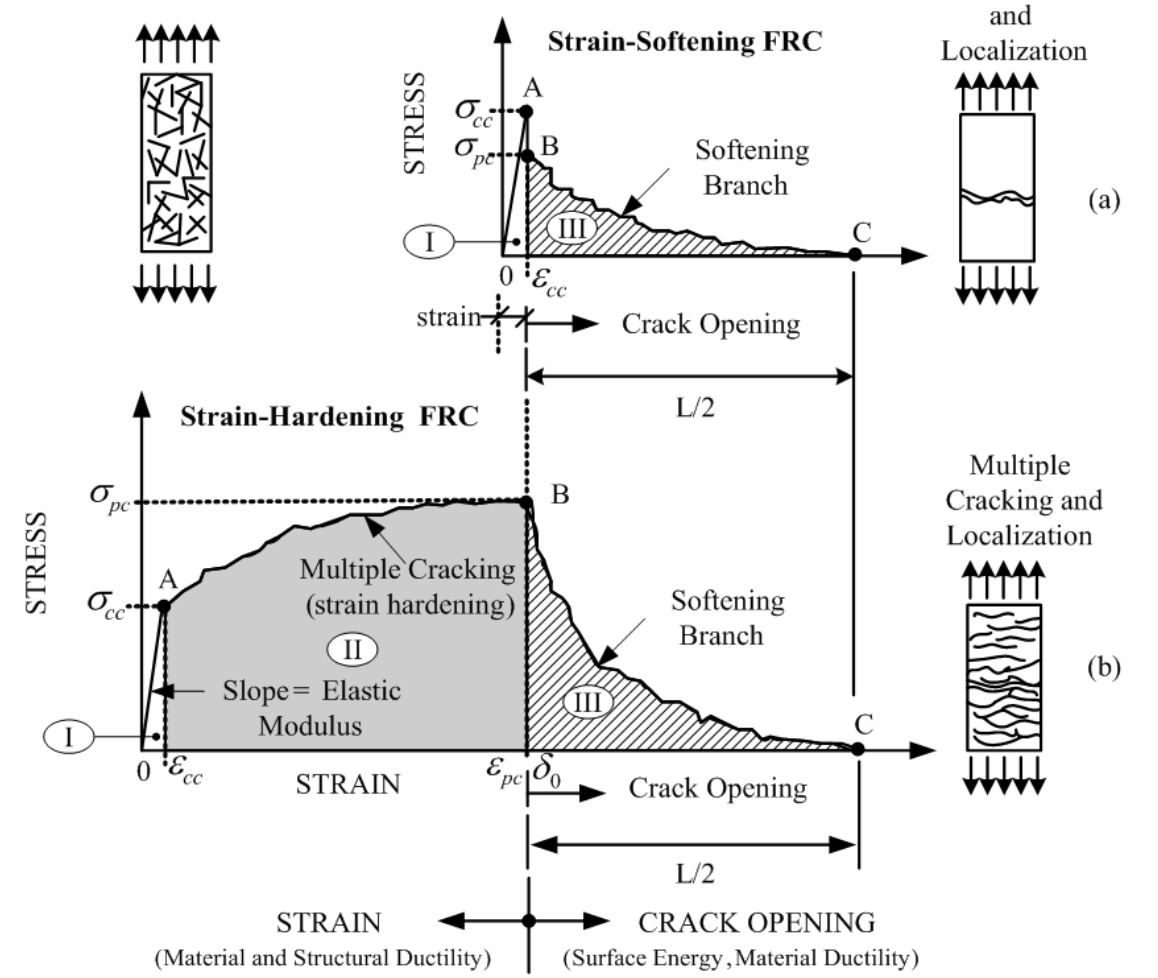
Figure 1. Typical tensile strain softening and hardening behavior of FRC and high-performance steel-fiber reinforced cement composites (HPSFRC) reprinted with permission from